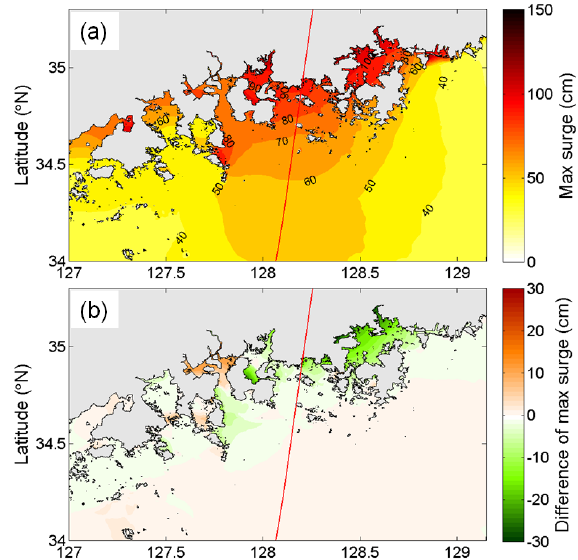
Figure 12. Spatial distribution of the storm surge during Typhoon Sanba ( (a) Maximum cumulative storm surge height; (b) difference of maximum surge considering the land roughness